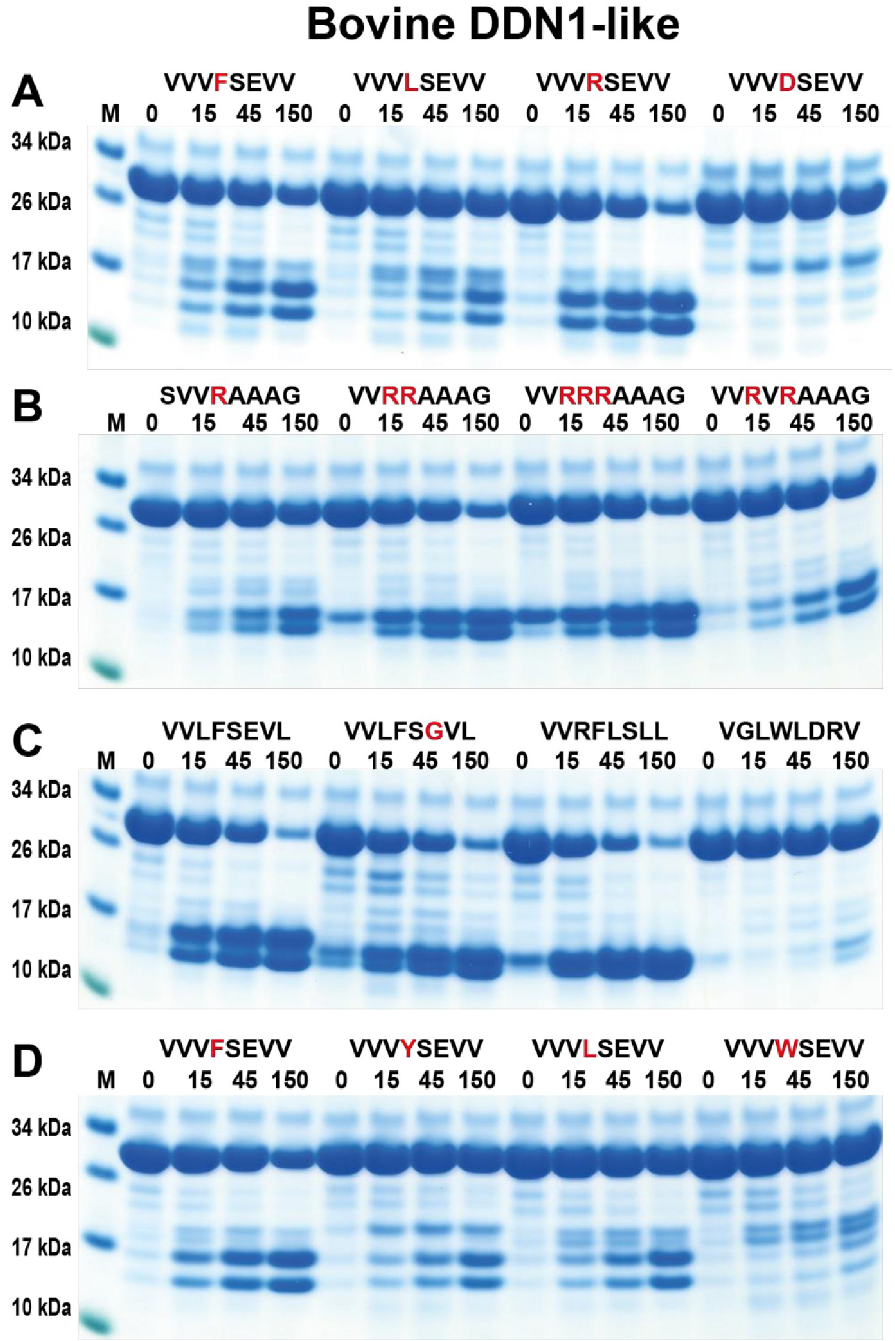
Fig 12. Analysis of the cleavage specificity of bovine duodenase DDN1-like using recombinant protein substrates. Panels A to D shows the cleavage of several substrates by the bovine DDN-like. The sequence of the different substrates are indicated above the pictures of the gels. The time of cleavage in minutes is also indicated above the corresponding lanes of the different gels. The uncleaved substrates have a molecular weight of ~25 kDa and the cleaved substrates appear as two closely located bands with a size of 12–13 kDa. Residues of particular interest and that may differ between different substrates are marked in red for an easy identification.